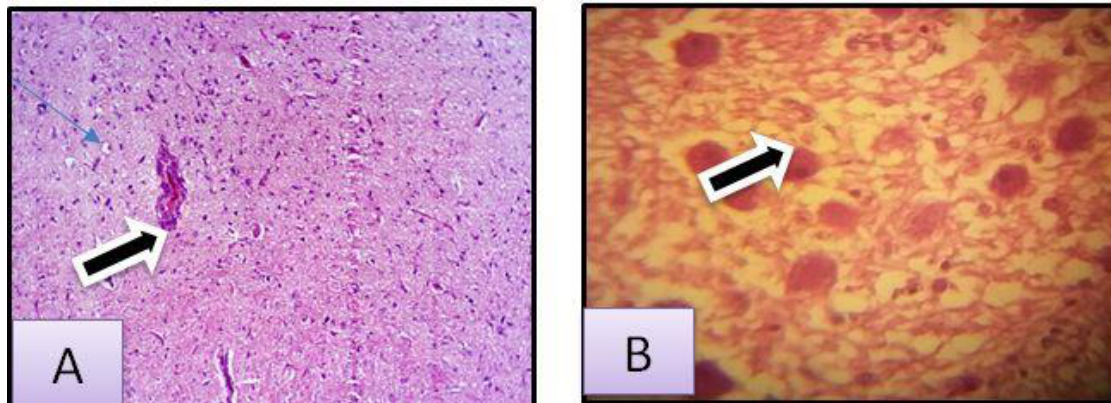
Fig. 8: A: brain section ; black arrow showed congestion of blood vessels while blue arrow showed glial cell(gliosis) X 10,while section. B: showed central chromatolysis of neuron (in which the neuron showed spherical perikaryo and loss of nuclei (black arrow) X 40